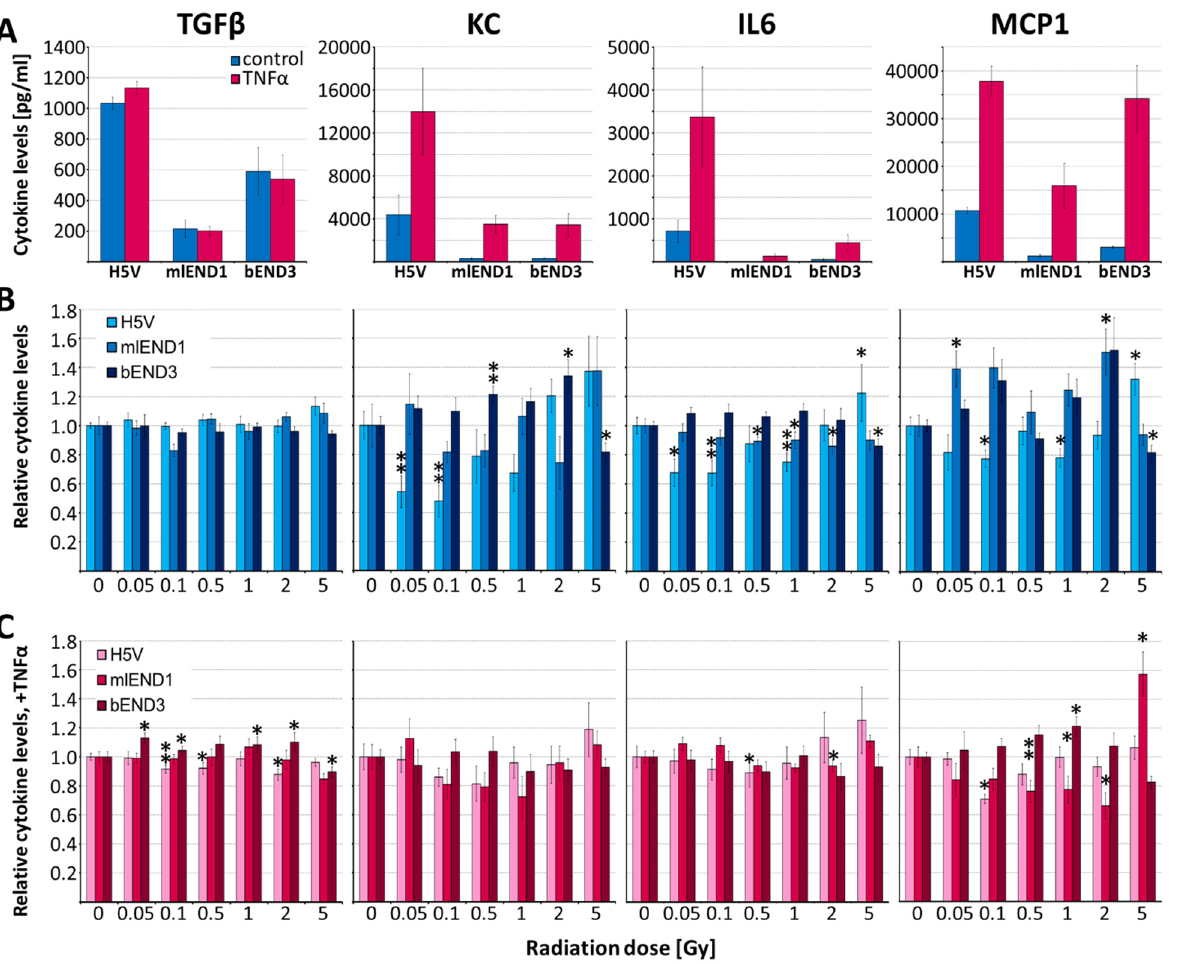
Figure 5. Concentration of TGF β , KC, IL6 and MCP1 in supernatants of H5V, mlEnd1 and bEND3 endothelial cell lines. ( A ) Effect of TNF α (5 ng/mL) compared to untreated control, absolute values. ( B , C ) Dose-dependent effects of IR without ( B ) TNF α costimulation, relative to 0 Gy control samples (=1), and with TNF α costimulation ( C ) relative to TNF α -stimulated, 0 Gy control samples (=1) 24 h after IR. Asterisks indicate significant differences for each cell line (*, p ≤ 0.05; **, p ≤ 0.01; 3 experiments per cell line, each in quadruplicates).